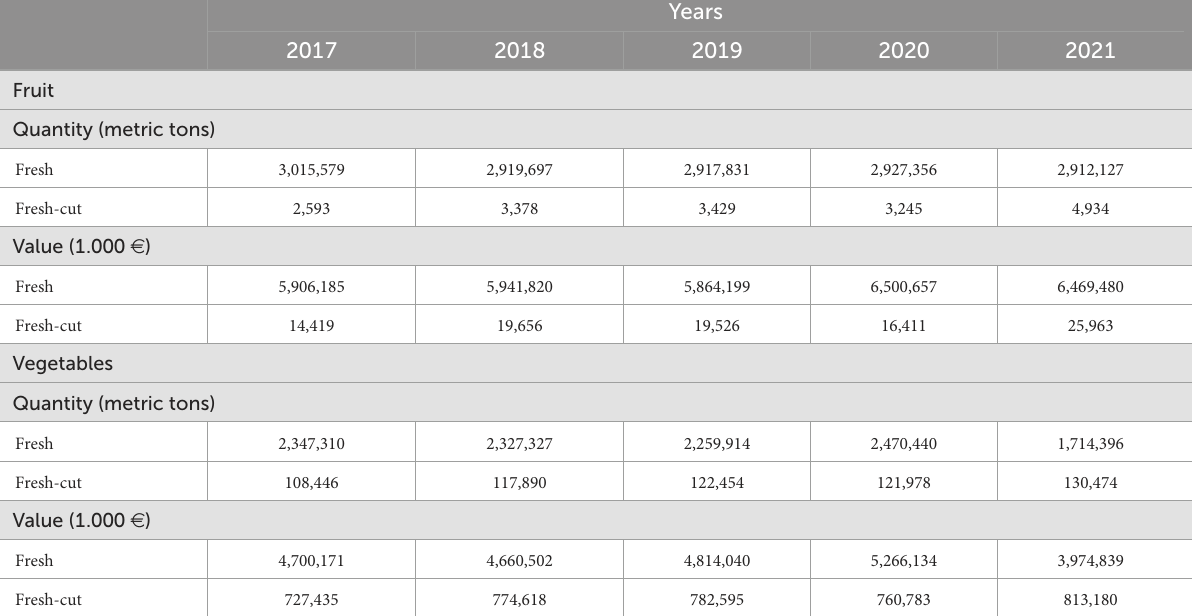
TABLE 1 Quantity and value of various fruits and vegetable processing categories sold in the market: Years